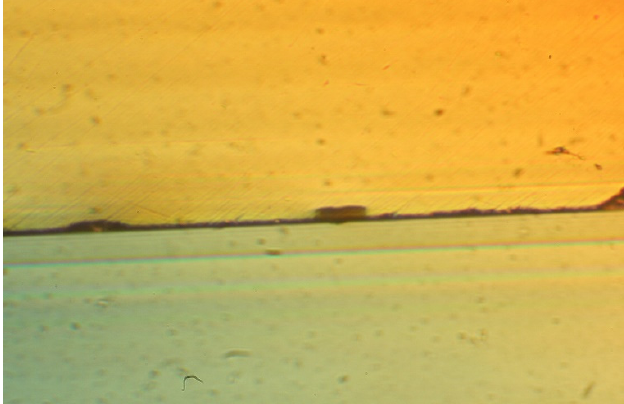
Figure 7. Interference phase contrast microphoto of the end face (in the centre of the image) of a channel waveguide written in an Er: tungsten-tellurite glass with a focused beam of 11 MeV C 4+ ions. Irradiated fluence was 4.6 · 10 14 ions/cm 2 . Width of the rectangular channel waveguide is 15 µ m. Depth of channel waveguide is about 3.3 µ m, which agrees well with the predicitons made from the SRIM simulations presented in Figure 3. A Zeiss Peraval microscope was